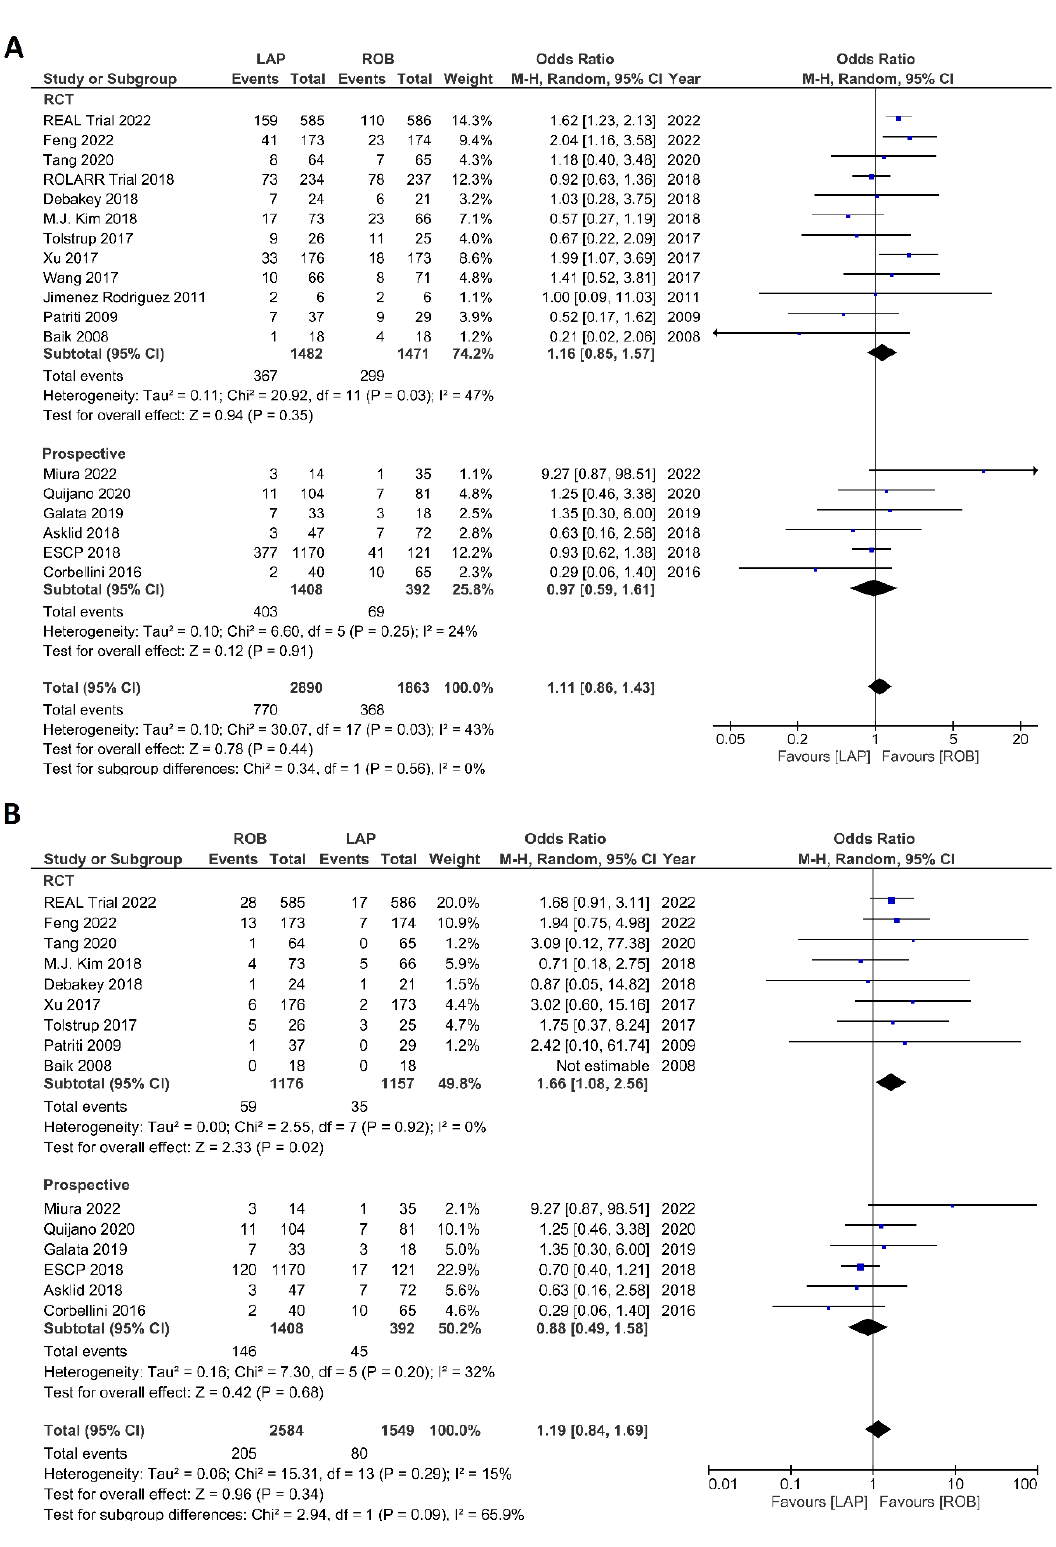
Figure 9. Forest plots comparing ( A ) postoperative complications [6,17–19,23,34–42,44,45,48,51,53] and ( B ) major complications [6,17,18,23,35,37,38,40–42,44,45,48,51,53] between robotic and laparoscopic rectal resection (blue boxes representing odd ratios, arrows representing 95% confidence intervals, and diamonds representing point estimates of pooled odd ratios or mean differences).